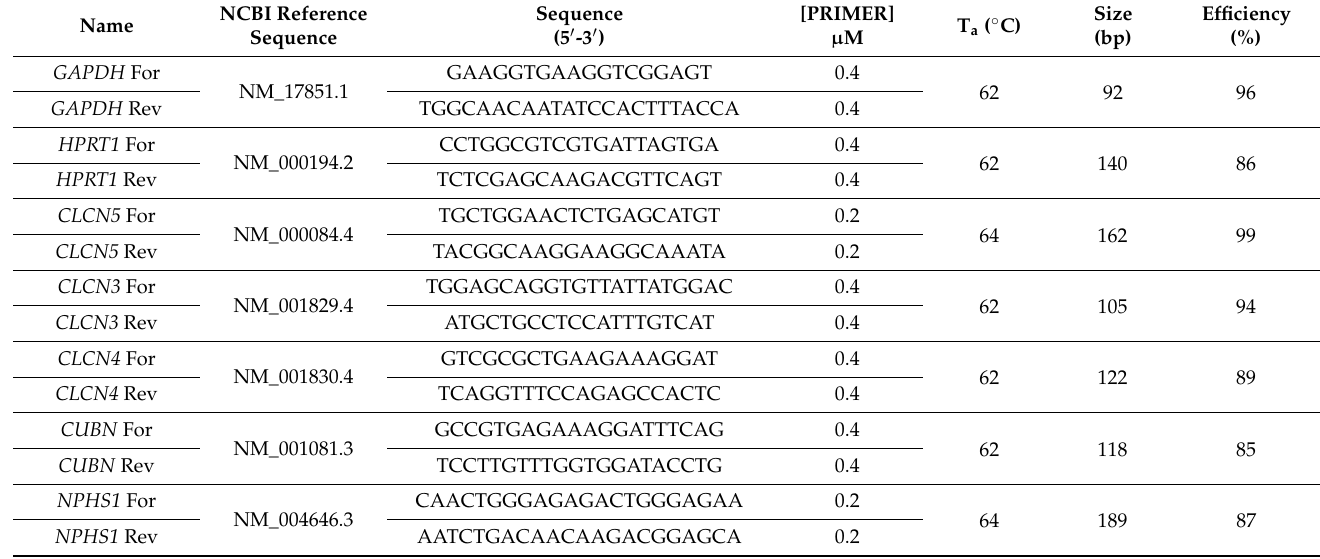
Table 3. Primer used in Real Time PCR analyses and Real Time PCR amplification conditions.